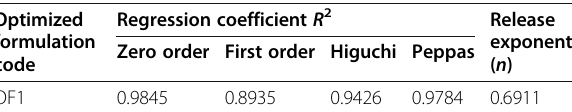
Table 6 Model fitting results of optimized chitosan-CMI